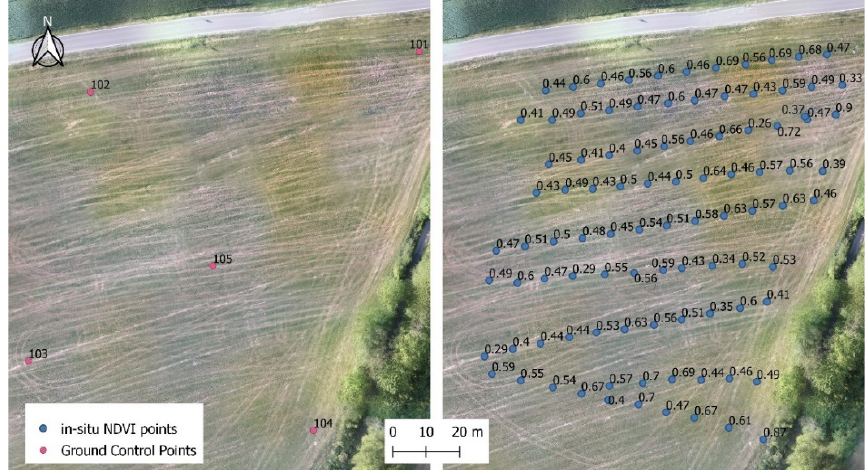
Figure 2. Study points in the examined field where regular in situ NDVI measurements were